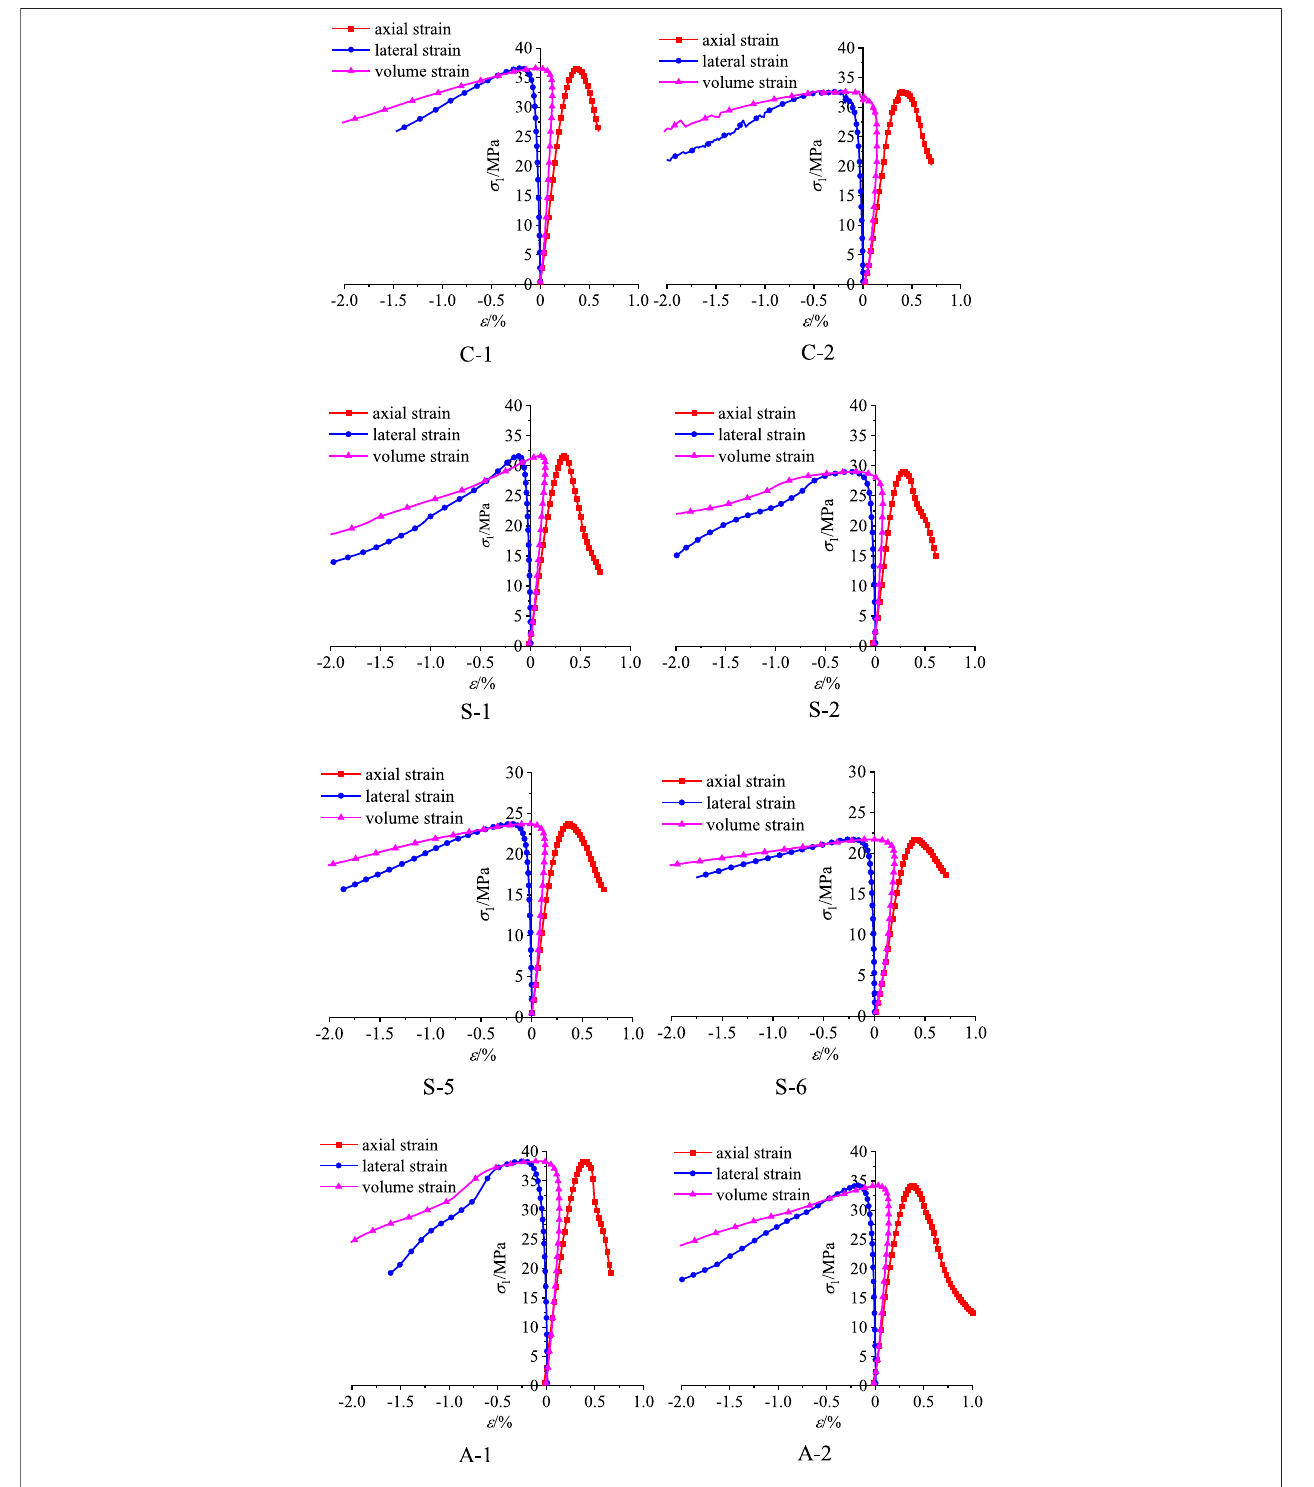
FIGURE 5 | Stress-strain curves of the samples containing nano-SiO 2 were labeled S (a total of eight samples). The saturated concrete samples containing nano-Al 2 O 3 were labeled A (a total of eight samples). The saturated concrete